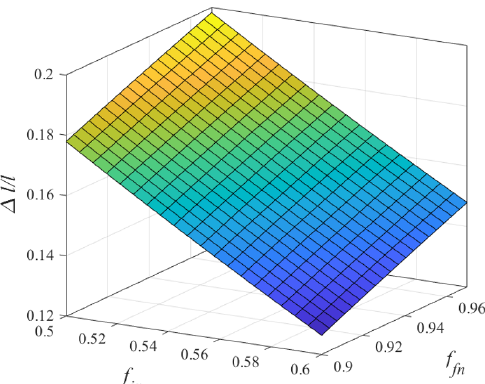
Figure 13. Shrinkage as a function of initial f in and final f fn densities according to correlations given by Equation